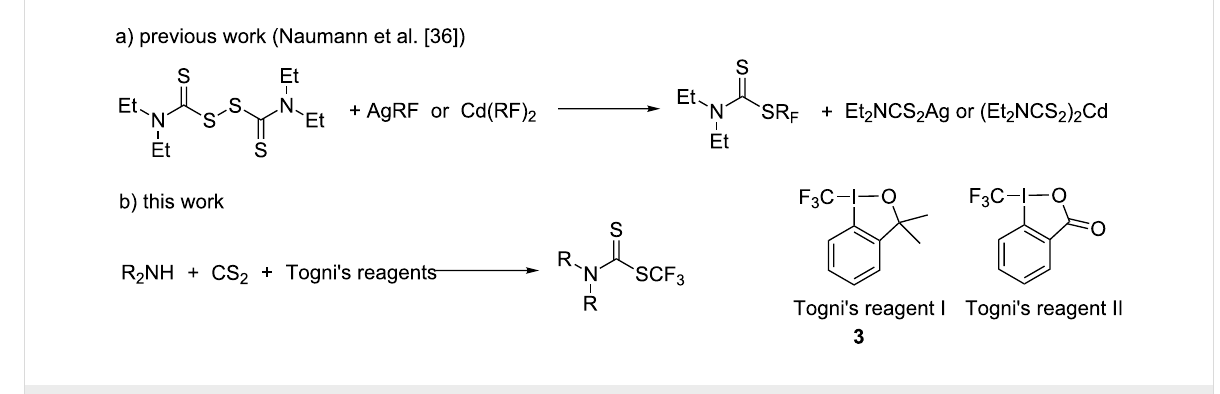
Scheme 1: Synthetic routes for the preparation of trifluoromethyl